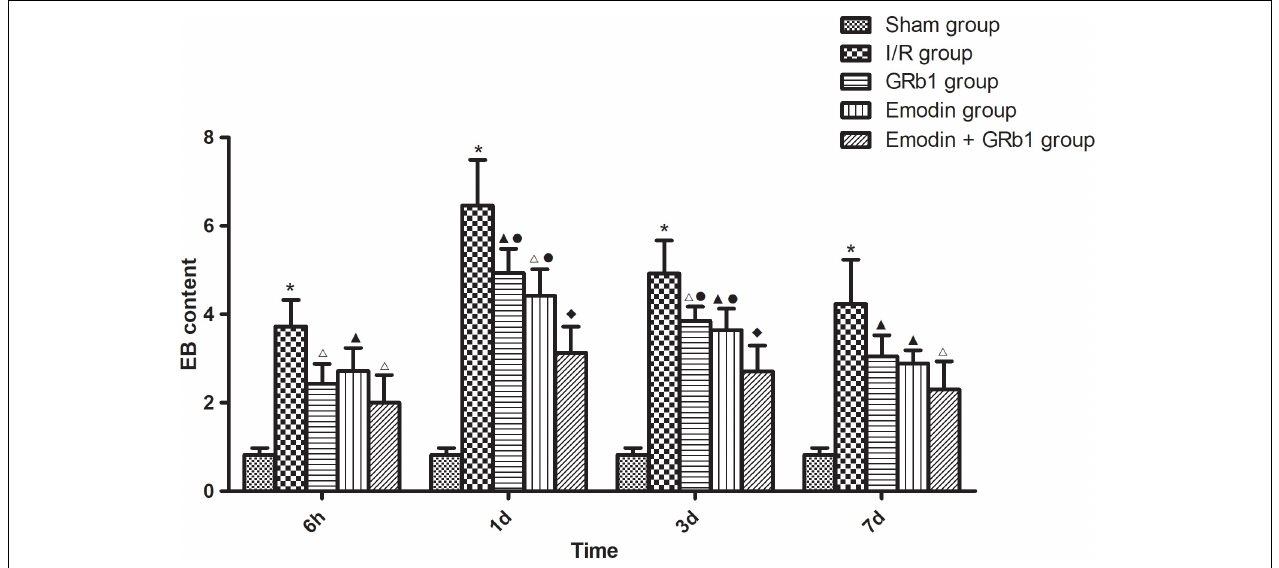
FIGURE 2 | The EB content in different groups after I/R in rats (mean ± SD, n = 5). Evans blue leakage experiments for determining BBB permeability after I/R in rats in four sub-groups at 6 h, 1d, 3d, and 7d. One-way analysis of variance (ANOVA) was used for multiple group experiments comparisons and followed by Dunnett test for comparison of two groups within the multiple groups. ∗ p < 0.001, compared with Sham group. (cid:78) p < 0.05, (cid:77) p < 0.01, (cid:7) p < 0.001, compared with I/R group. • p < 0.01, compared with the Emodin+GRb1